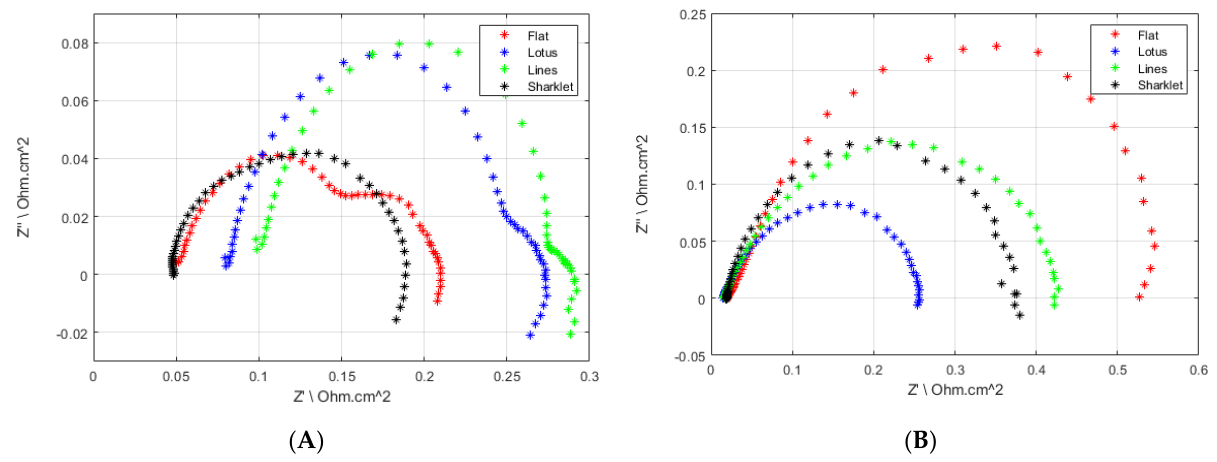
Figure 4. Electrochemical impedance spectroscopy at 0.4 V, 25%( A ) & 100%( B ) RH.